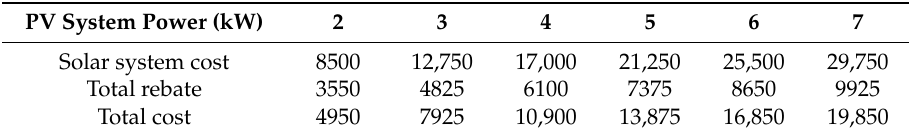
Table 4. Photovoltaic (PV)